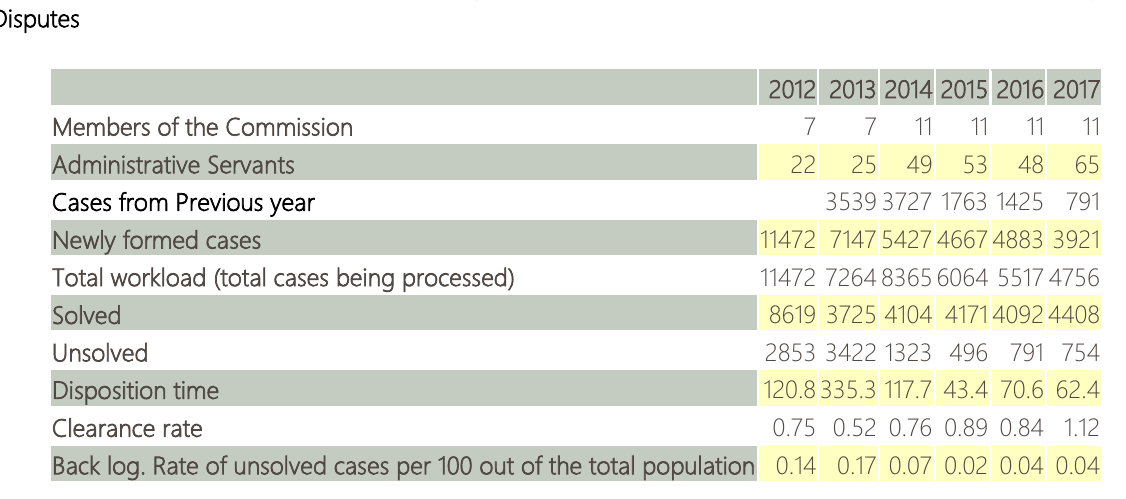
Table 2: State Commission for Decision Making in Second Instance Administrative Procedures and Employment